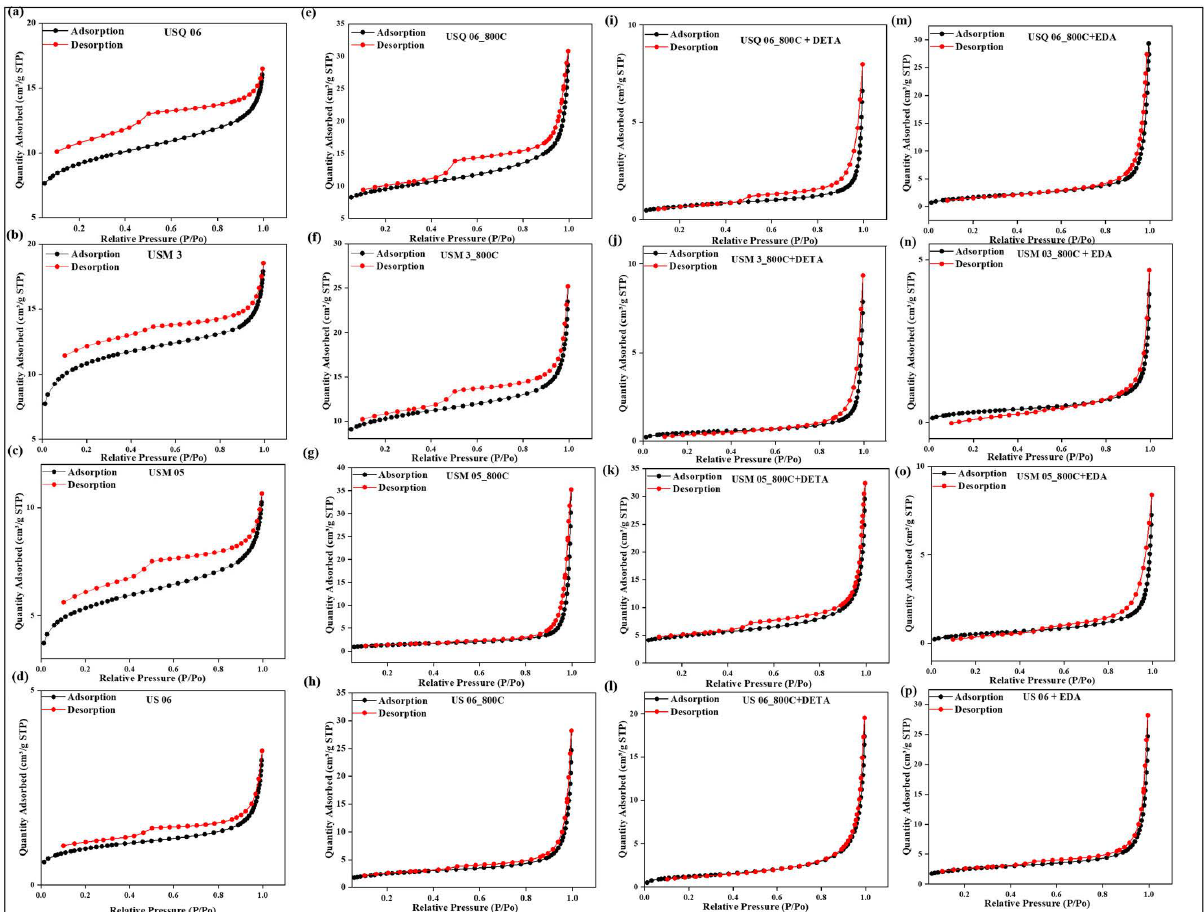
Figure 3. Impact of various treatments on the N 2 Isotherm curves of Raw shale ( a – d ), Spent shale ( e – h ), DETA-modified spent shale ( i – l ), and EDA-modified spent shale ( m – p